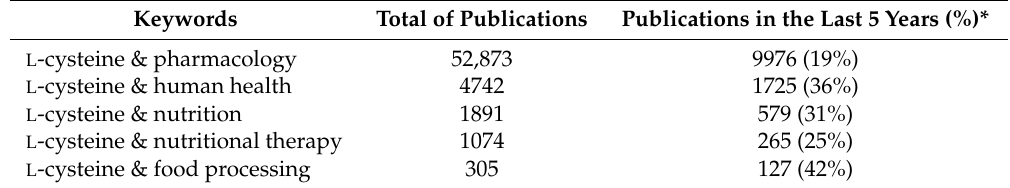
Table 1. Number of publications included in the database for this work (Database: PubMed). * %: calculated over the total number of publications compiled from each combination of